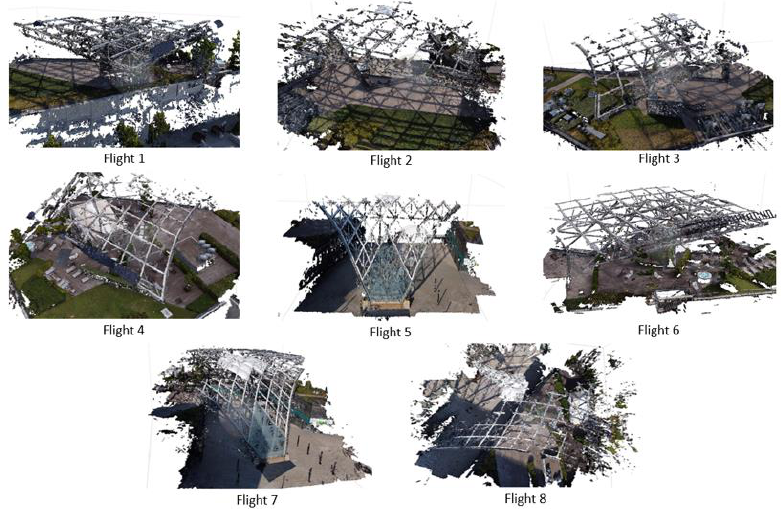
Figure 11. Photogrammetric blocks divided into eight flight missions.